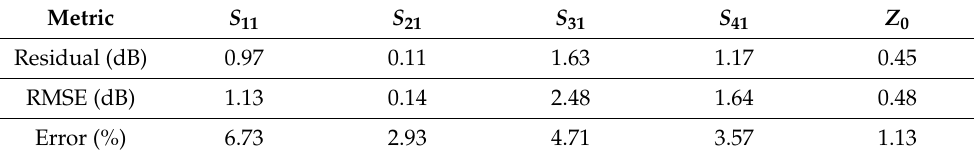
Table 2. Artificial Neural Network (ANN) model prediction performance in microstrip line